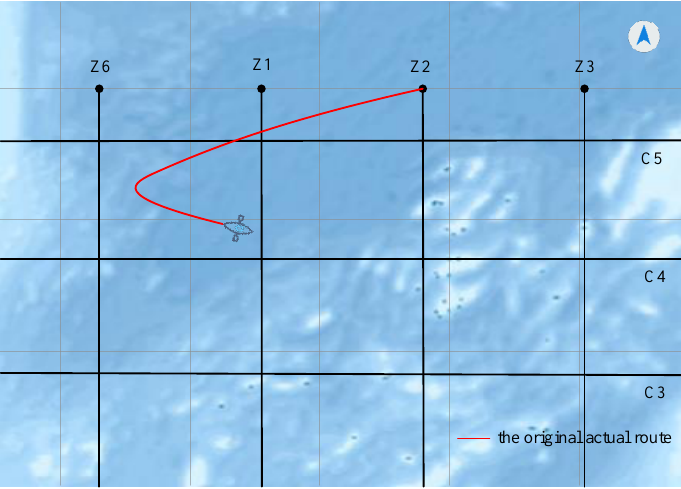
Figure 12. The original system ’ s navigation trajectory.